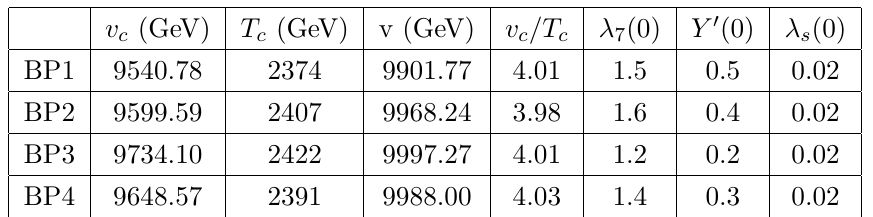
Table 1 . Benchmark parameters of the model and other details of the FOPT in conformal scoto- genic